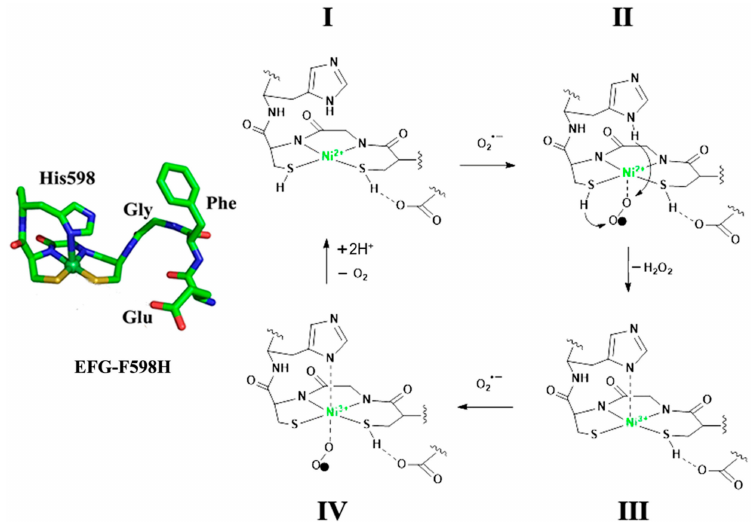
Figure 9. Proposed Outer-Sphere Catalytic Mechanism for EFG-F598H. State I: the begin of the reaction; State II: superoxide anion attacks the Ni site, the first half reaction; State III: His-on Ni 3+ state; State IV: Superoxide also approaches the nickel center, the second half